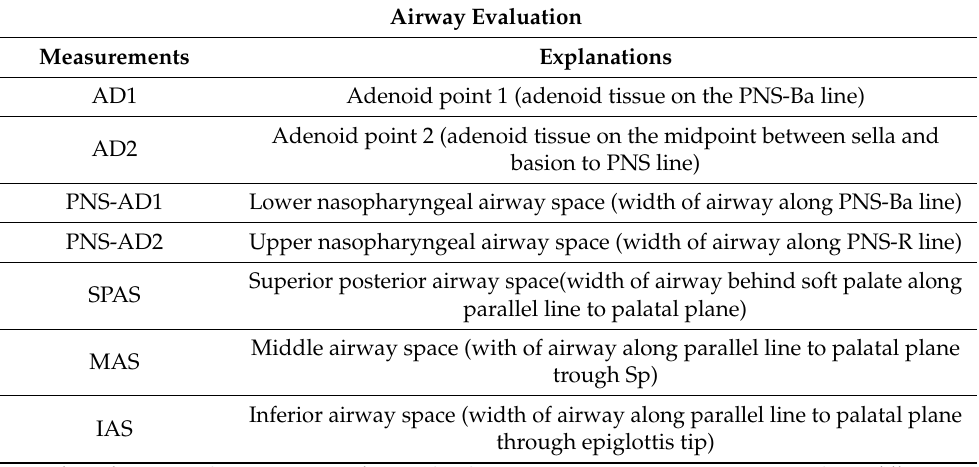
Table 1. Criteria for airways space